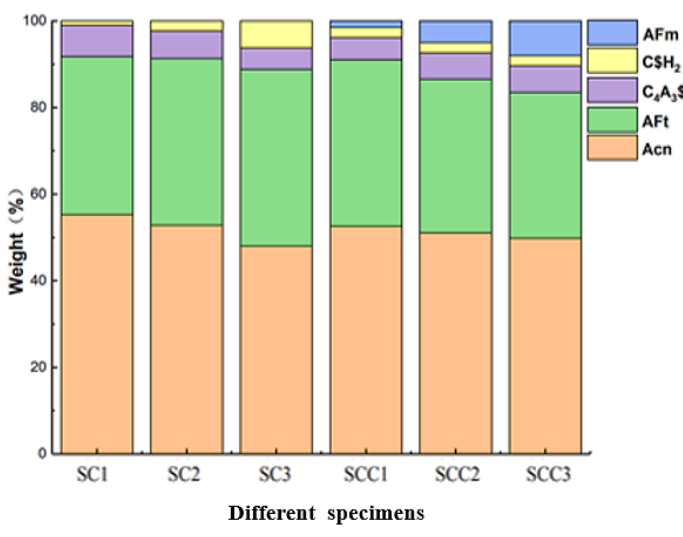
Figure 7. Percentage mass content of samples SC1-SC3 and SCC1-SCC3 at 3 days of age.